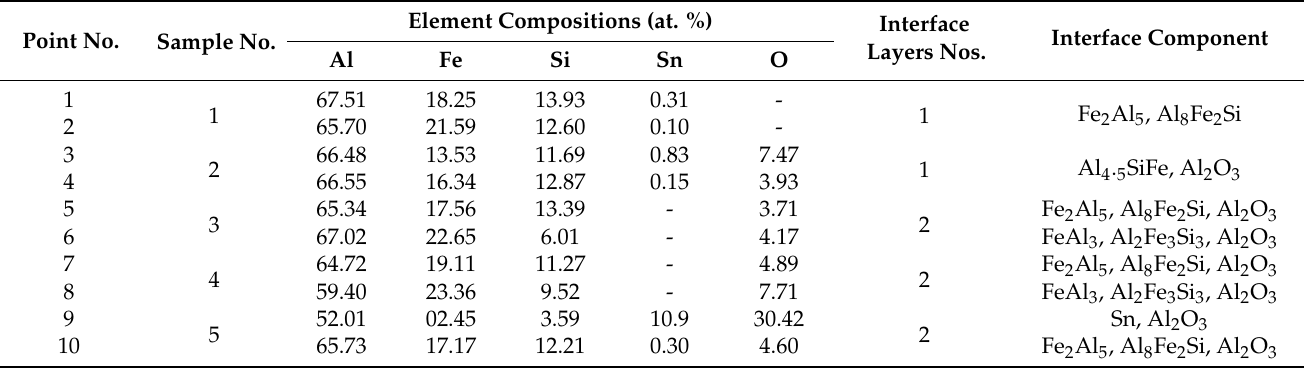
Table 4. Results of EDS analysis for points indicated in Figures 6–8. Point